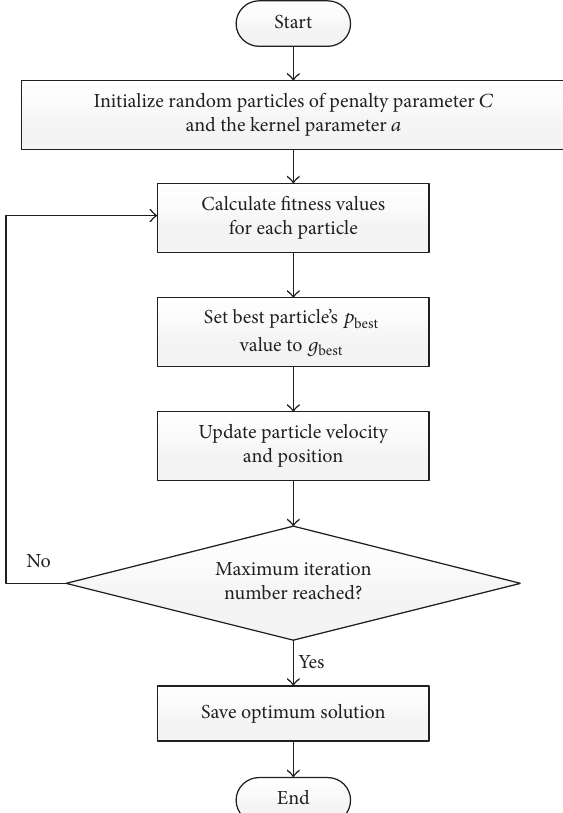
Figure 3: Flowchart of the PSO optimization